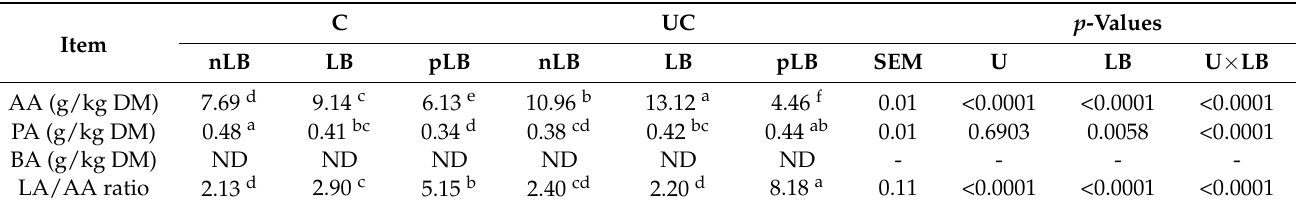
Table 1. Effect of urea treatment and L. buchneri forms on fermentation indices of corn